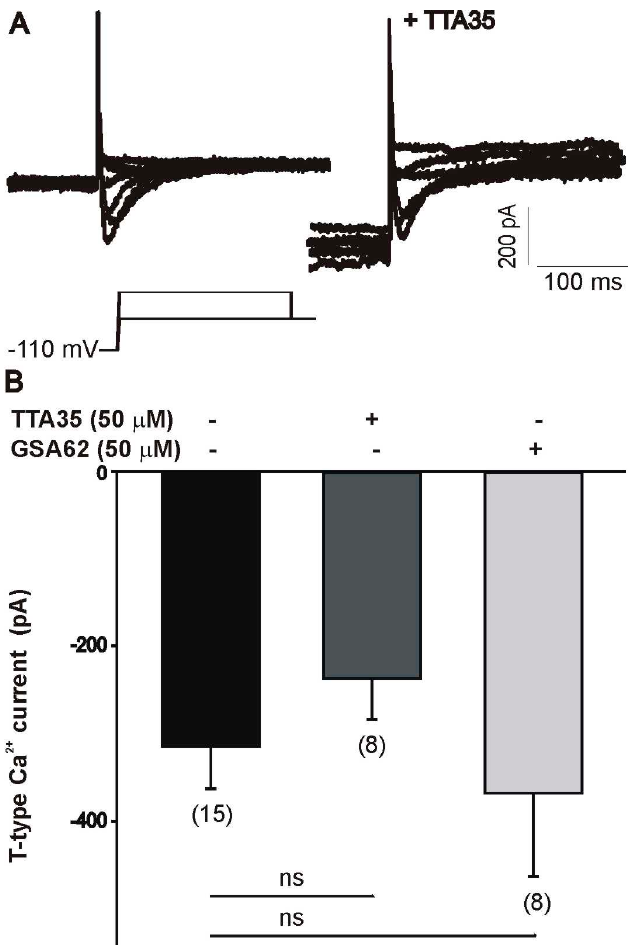
Figure 6. Inhibition of voltage-gated calcium channel currents. Effect of TTA 35 or GSA 62 on T-type calcium currents in ND7/23 cells. ( A ) Typical T-type calcium currents generated in an ND7/23 cell before and after treatment with 50 µM of TTA 35. T-type calcium currents were generated by a voltage step up to − 20 mV from a holding potential of − 110 mV. ( B ) Treatment of ND7/23 cells with 50 µM of TTA 35 or GSA 62 did not alter the amplitude of the T-type calcium currents generated by a voltage step to − 20 mV. NS represents no statistically significant difference vs. vehicle.